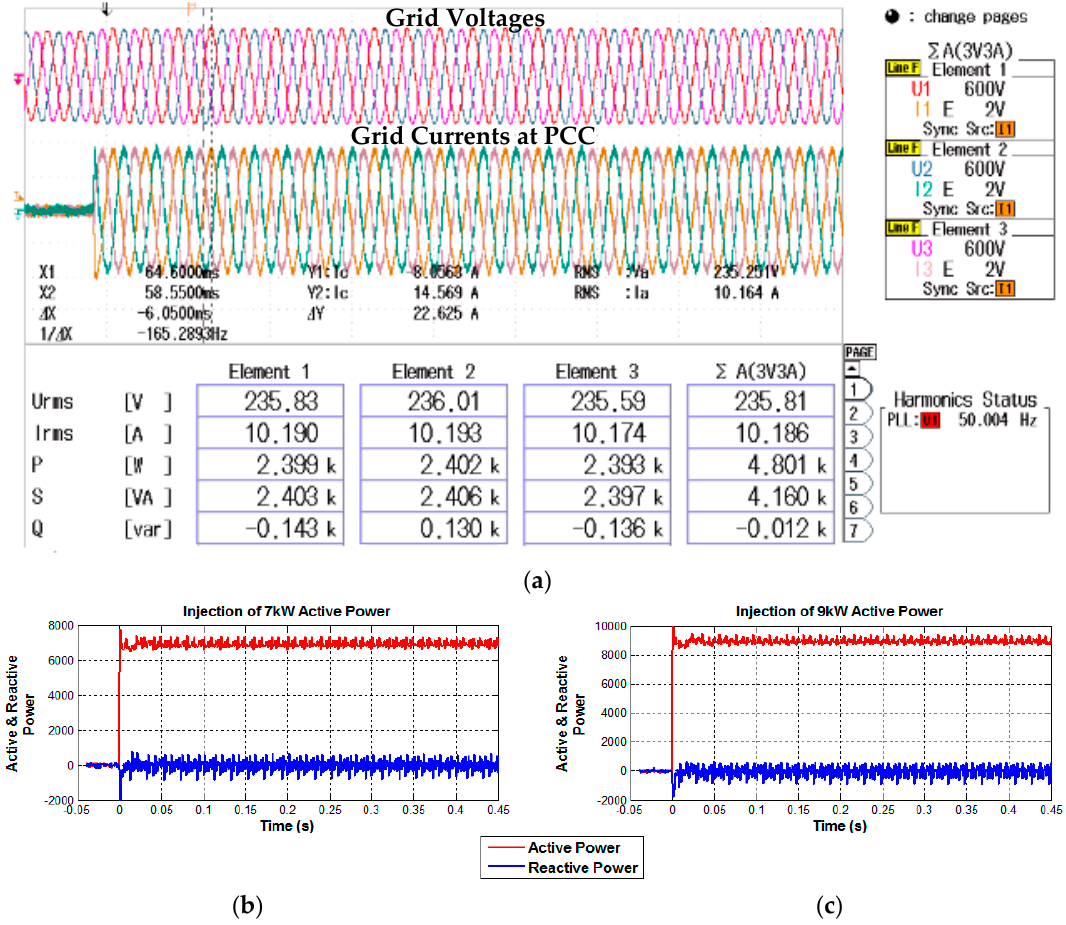
Figure 20 . Injection of purely active power: ( a ) Results captured from oscilloscope with power reference step is set from 0 to 7.5 kW (0.75 p.u); ( b ) Results captured from the control desk when power reference is set to 7 kW (0.7 p.u); ( c ) Results captured from the control desk when power reference is set to 9 kW (0.9 p.u).